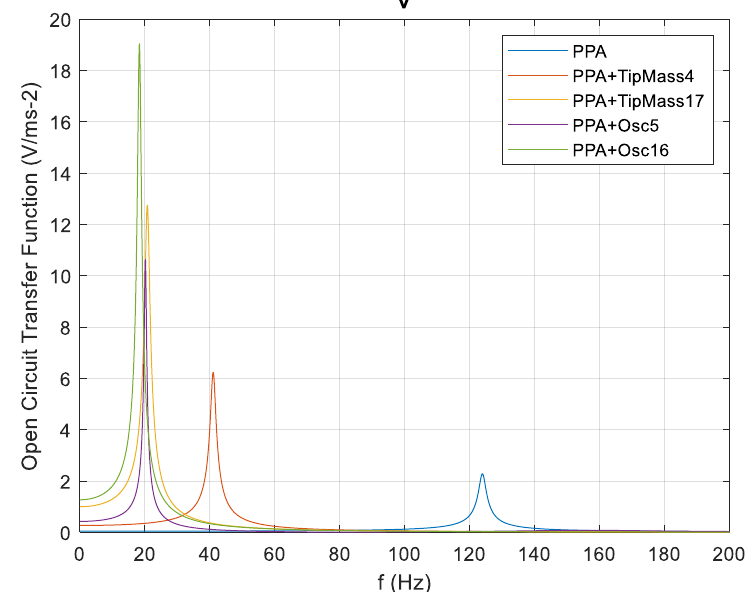
ff ect of the tuning devices on the open-circuit frequency response function Figure 7. Effect of the tuning devices on the open-circuit frequency response function (FRF). Figure 7. E